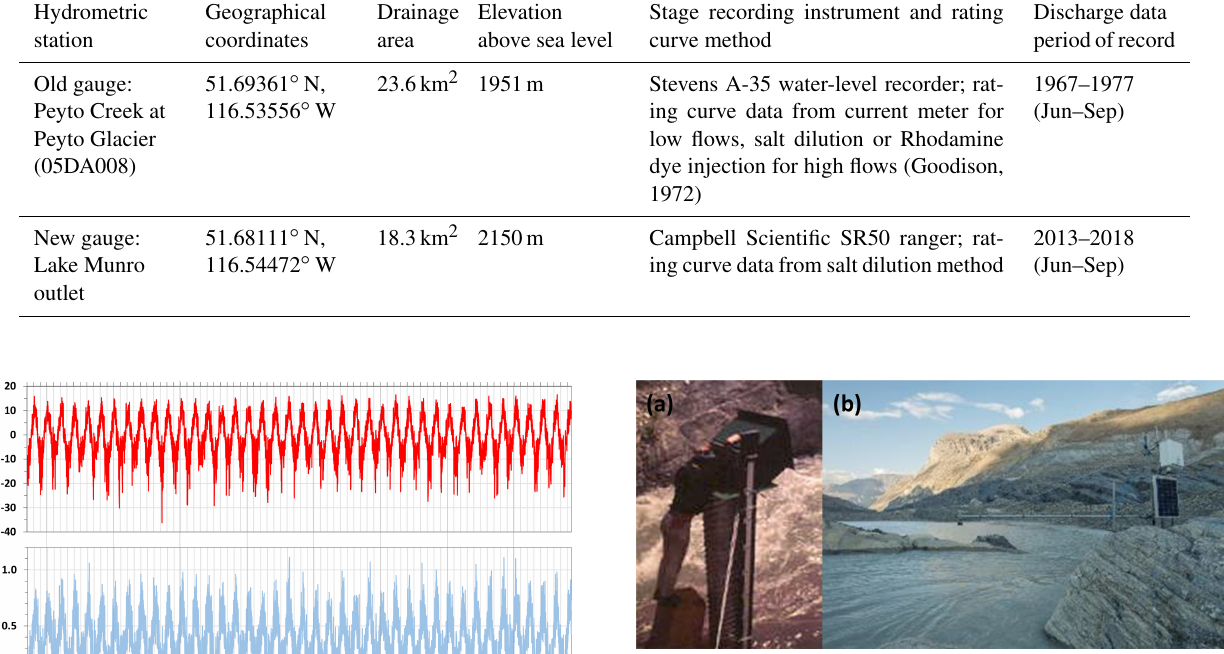
Figure 14. Gauge sites: (a) old IHD hydrometric gauge on Peyto Creek, August 1970, and (b) new hydrometric station at the Lake Munro outlet. Photographs by D. Scott Munro (a) and Angus Dun- can (b)